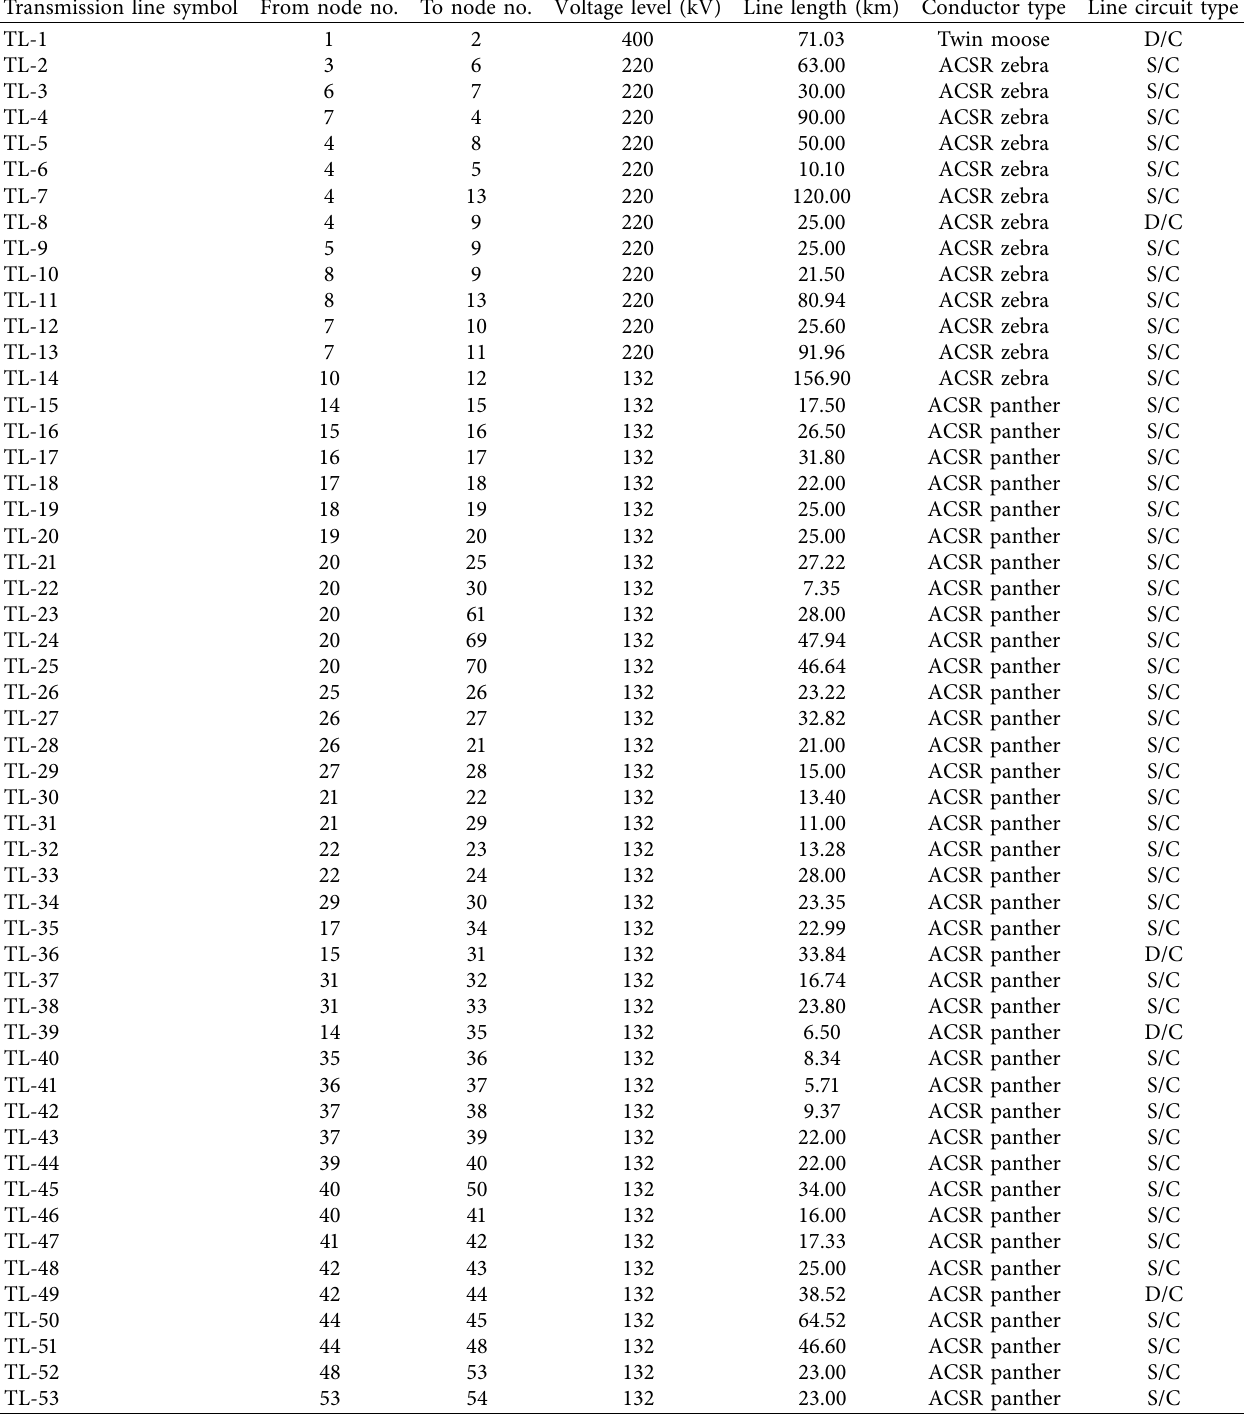
Table 4: Description of transmission lines